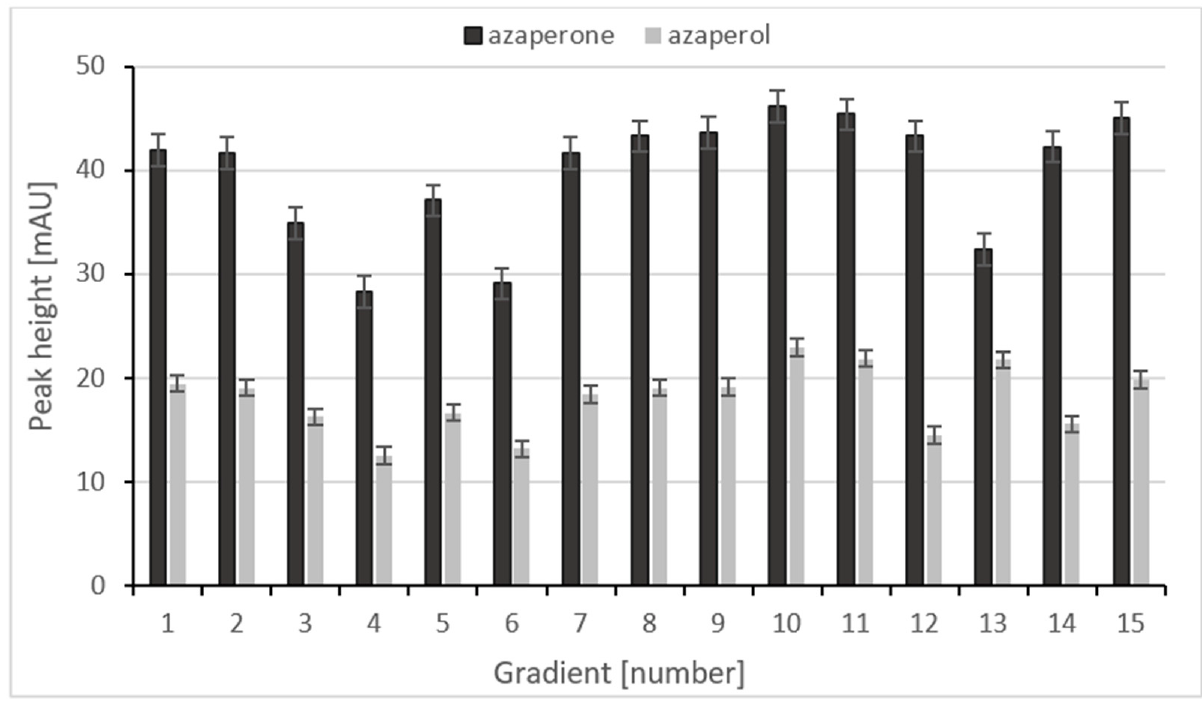
Figure 5. The relationship between the peak height and the gradient.